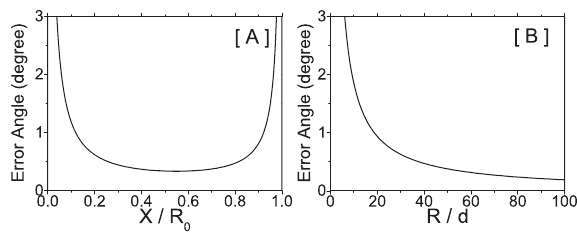
Fig. 2. The error range obtained by MTA tests, selecting only one contour plane in the certain flux rope model. The error is defined as the angle between the model z axis and the MTA resulting axial orientation. (a) The error as a function of X (the constellation’s closest distance to the axis, normalized to flux rope radius R ), when R is 50 times greater than the satellites’ separation d . (b) The error versus flux rope radius R (normalized to d ) in a certain type of Cluster trajectory with X to be 0 . 707 R